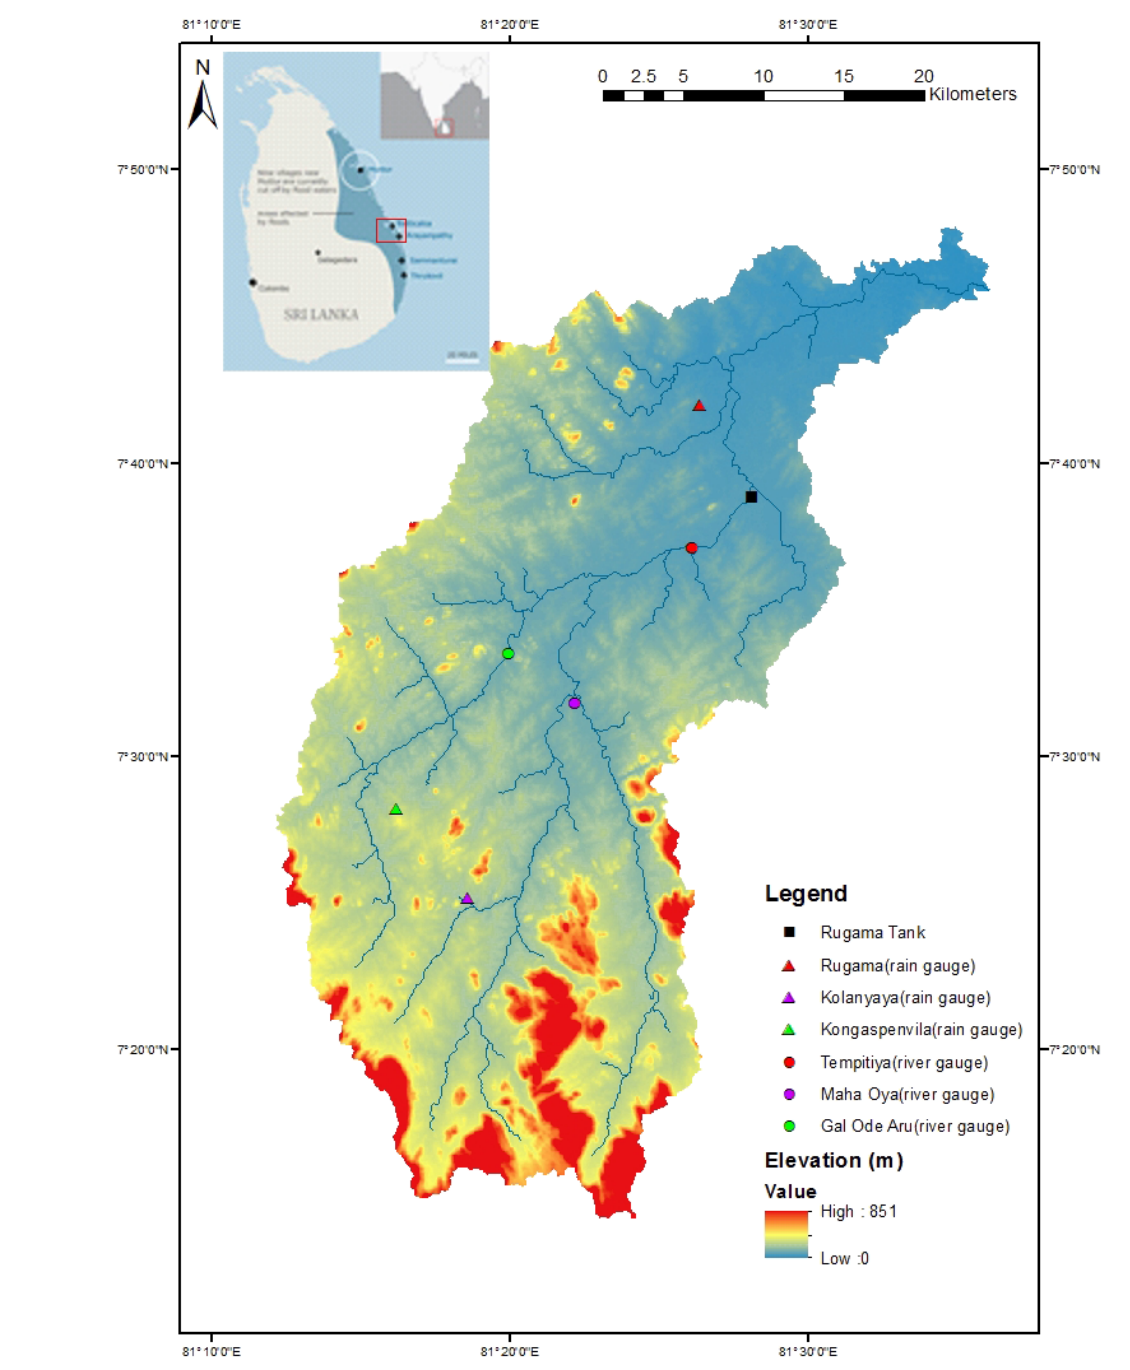
Figure 1. Location map of Mundeni Aru River Basin in the Eastern Province of Sri